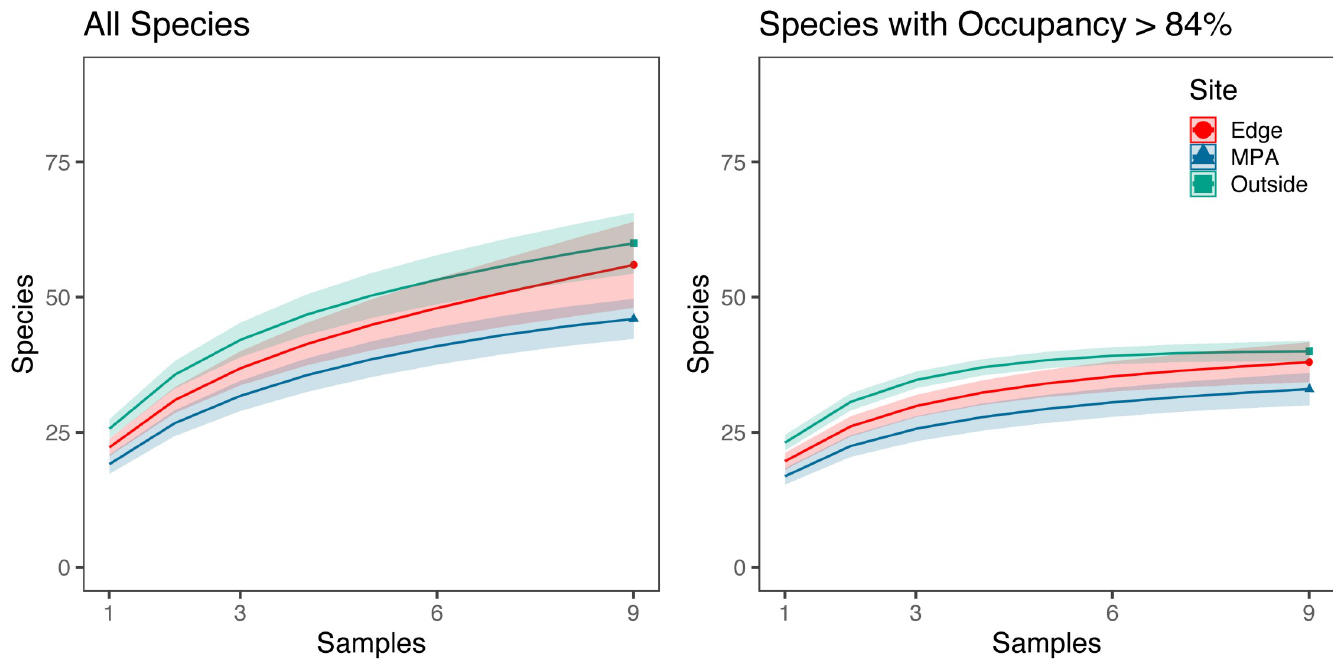
Fig 3. Species rarefaction curves. a ) Species rarefaction curves for all fishes found at each site across three 1 L replicates taken at three locations along a 100m transect. b ) Species rarefaction curves for fish species with occupancy rates above 84% found at each site across three 1 L replicates taken at three locations along a 100 m transect. Sample coverage estimates were higher for species with occupancy rates above 84% (96.7–99.8%) than for all species (88.9%-94.4%). For species with occupancy rates above 84% sample coverage estimates ranged from 87.3–90.0% for only three 1 L